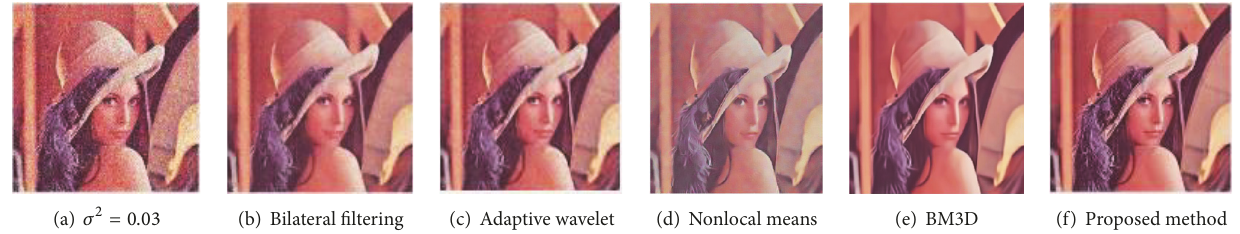
Figure 6: Image 1: comparison of various experimental results under noise variance 𝜎 2 = 0.03 .